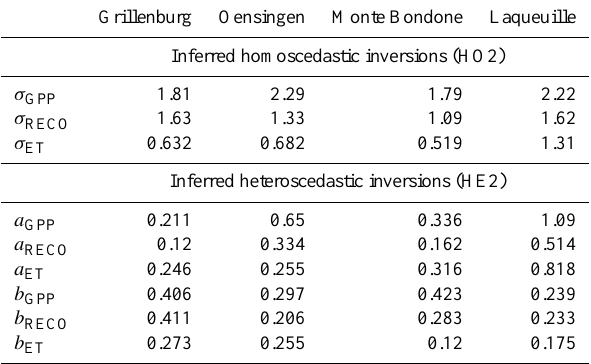
Table 5. Most likely standard deviation of the residual errors (HO2) and parameters of Eq. (7;